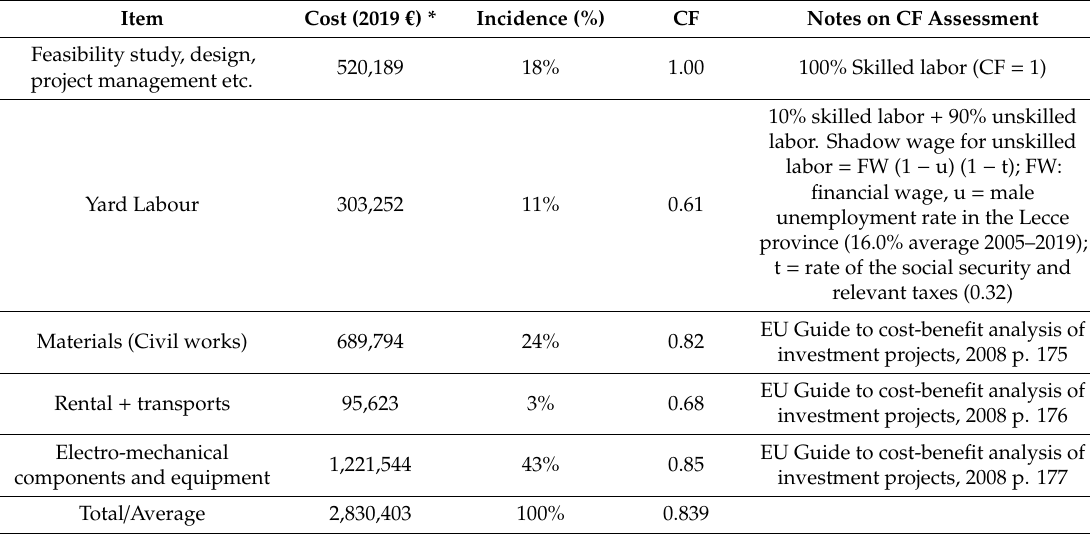
Table 1. Investment costs of the Gallipoli tertiary treatment plant and estimated Conversion Factors (CF) for the economic